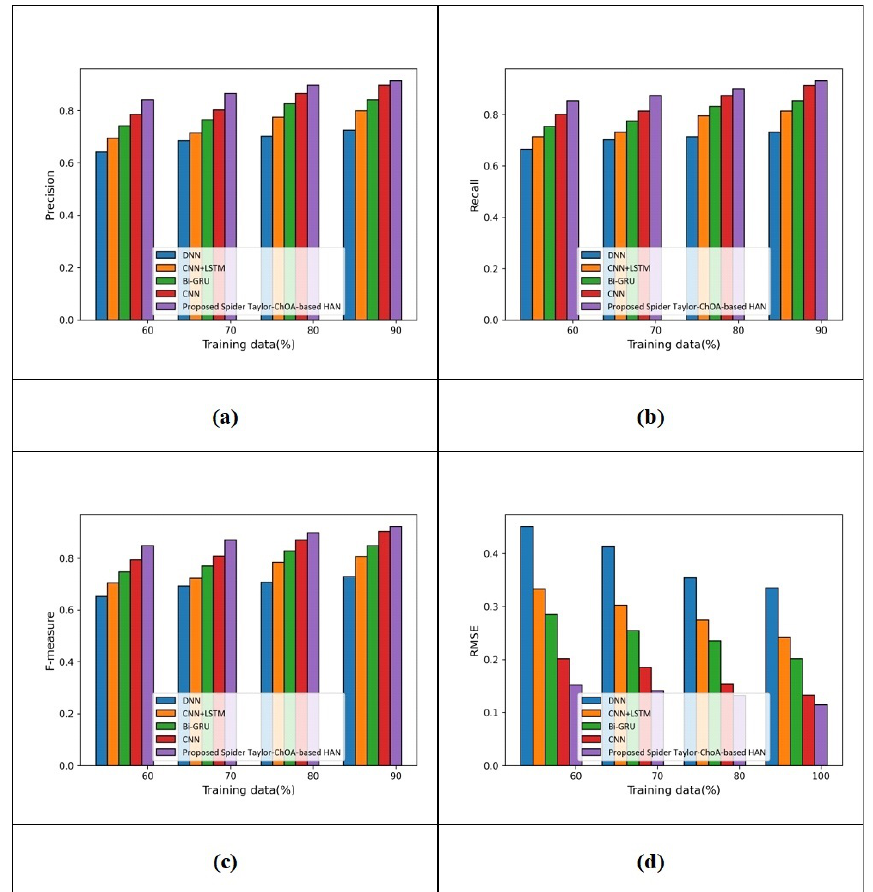
Figure 9. Results based on review rating prediction using Yelp 2014 datasets with ( a ) precision ( b ) recall ( c ) F-measure and ( d )